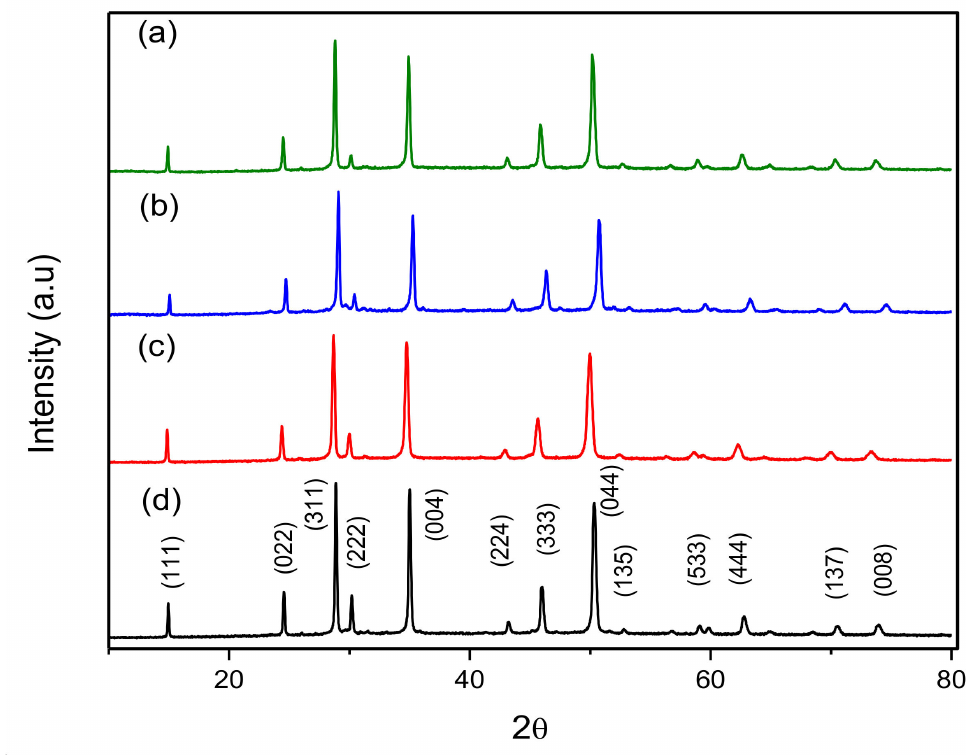
Figure 2. Representative powder XRD patterns at RT of ( a ) CuCr 1 . 4 Sn 0 . 6 S 2 . 3 Se 1 . 7 , ( b ) CuCr 1 . 6 Sn 0 . 4 S 2 . 3 Se 1 . 7 , ( c ) CuCr 1 . 4 Sn 0 . 6 S 1 . 7 Se 2 . 3 , and ( d ) CuCr 1 . 6 Sn 0 . 4 S 1 . 7 Se 2 . 3 phases showing the corresponding hkl Miller